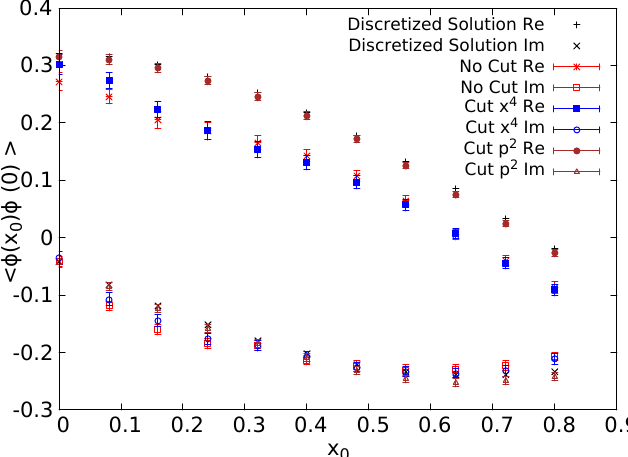
Figure 9 . Comparison of the unequal-time correlation function G ++ in thermal equilibrium from matrix mechanics (black crosses) with complex Langevin simulations carried out on a Schwinger- Keldysh contour of intermediate real-time extent x max = 0 . 8 . Here the forward branch of the 0 contour resides on the real-time axis and the backward contour tilts down to intersect with the imaginary axis at β (cf. b) in figure 3). The direct simulation based on the explicit EM scheme converges to an incorrect result given by the red data points. No improvement is observed for regularizing the φ 4 term (blue). The correct solution is recovered when regularizing the momentum term